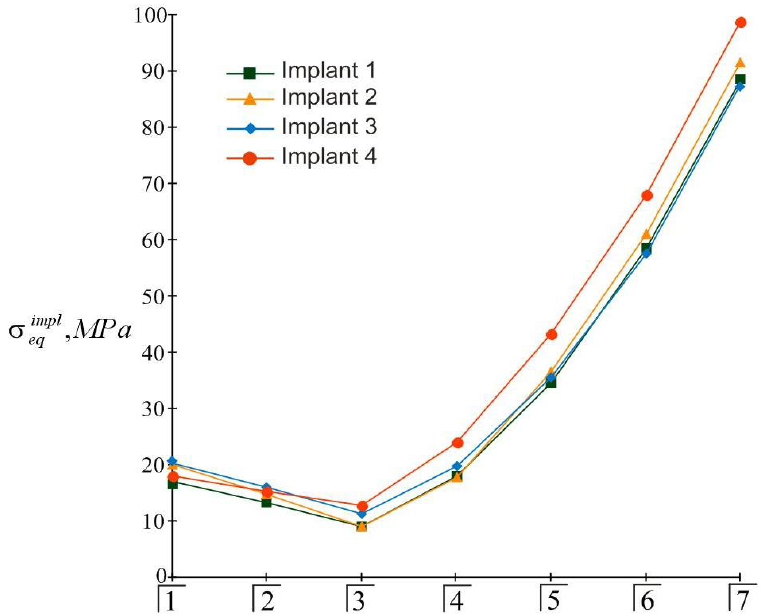
Figure 14. Comparative analysis of maximum equivalent stresses in implants at different localizations of the mastication load (the second variant of implant placement).